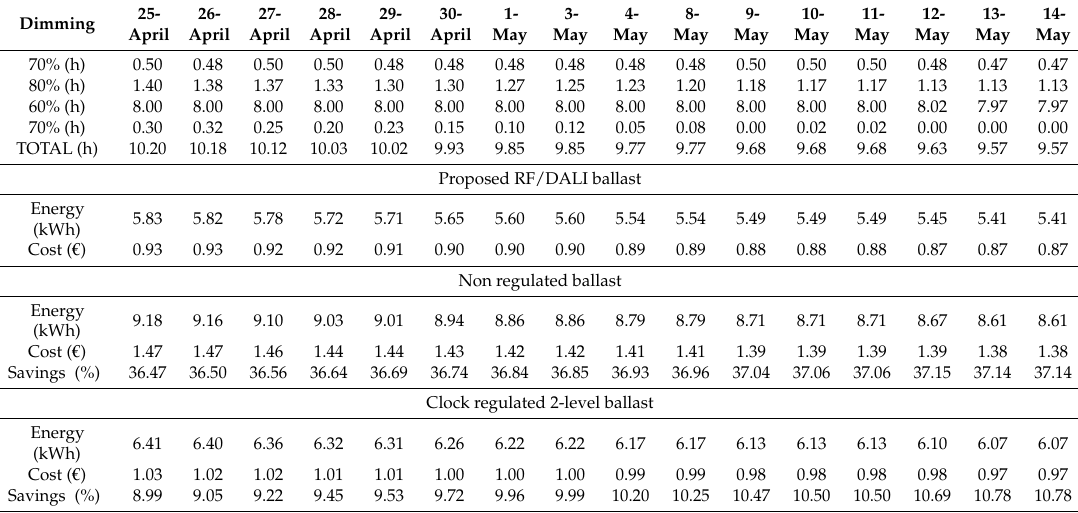
Table 2. Measured consumption: energy, cost and saving rate.